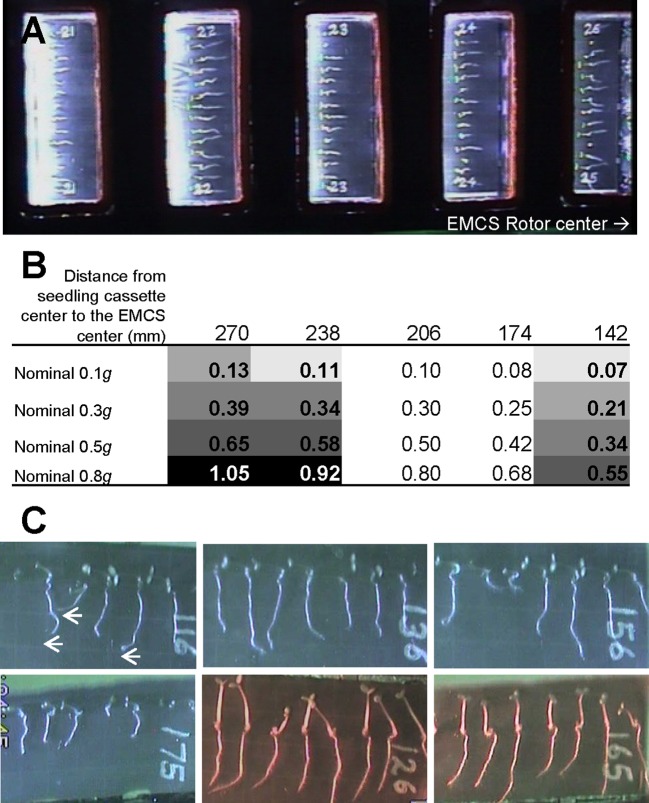
Setup of SG1/SG2 experiment on board the International Space Station. (A) Image of an experimental container with 5 seedling cassettes inside the European Modular Cultivation System (EMCS) with the direction to the EMCS rotor center included. (B) Calculated g-level in each of the five culture chambers depending on the distance to the EMCS centrifuge rotor (note that only samples in the 3 positions in bold were included in this analysis, cassettes at 174 and 206 mm from EMCS center did not contain wildtype samples) and different EMCS rotational speed (nominal g value). Different background grey tones are used to indicate the samples that were used as replicates for low gravity (0.09 ± 0.02g, 3 replicates), Moon gravity (0.18 ± 0.04g, 3 replicates), Mars gravity (0.36 ± 0.02g, 3 replicates) and reduced Earth gravity (0.57 ± 0.05g, 4 replicates) and 1g control (0.99 ± 0.06g, 3 replicates) in addition to the microgravity samples (stopped centrifuge, 4 replicates). (C) Closer view of 6 day-old seedlings growing within a seed cassette at microgravity (CC116), low g (0.07g, CC136), Moon g (0.21g, CC156) or 1g control (1.05g, CC175) conditions with blue light stimulation (from the left). Hypocotyls show a clear positive phototropism at any g-level but roots only show this tropism at microgravity (arrows). For comparison, seed cassettes at low g (0.07g, CC126) and 1g control (1.05g, CC165) conditions exhibiting root positive phototropism to red light stimulation (from the left) are provided (see Vandenbrink et al., 2016 for a detailed phototropism discussion).